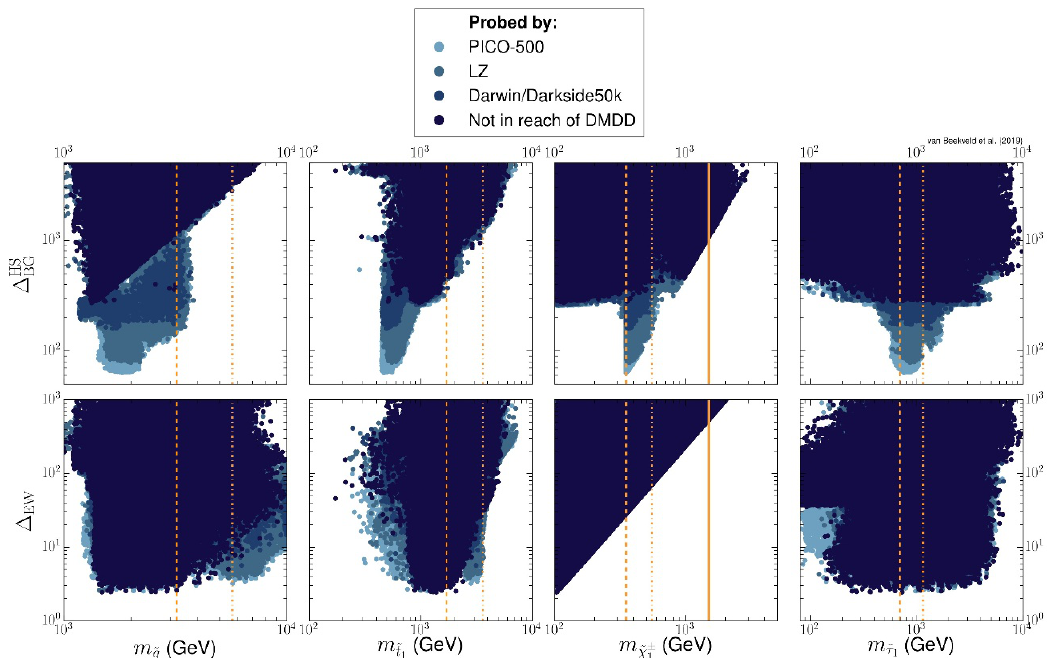
Figure 15 . The values for (cid:1) HS (top) and (cid:1) EW (bottom) against (from left to right) m ~ g , m ~ BG m and m ~ (cid:28) for all allowed pMSSM-GUT spectra. The masses are given in units of GeV. The ~ (cid:31) (cid:6) 1 1 color code and plotting order is the same as in (cid:12)gure 1. The dashed, dash-dotted and solid orange line shows the exclusion potential of the HL-, HE-LHC and CLIC on the masses of various SUSY particles (see table 1). The solid orange line in the chargino mass plot shows the exclusion potential of